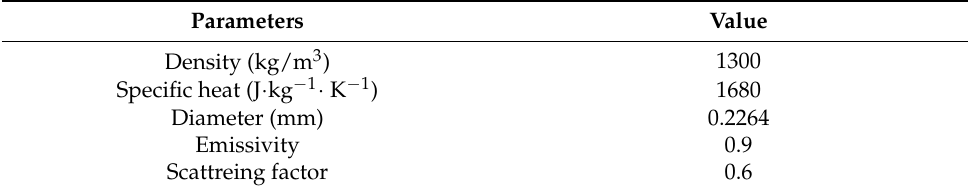
Table 2. Physical properties of the coal